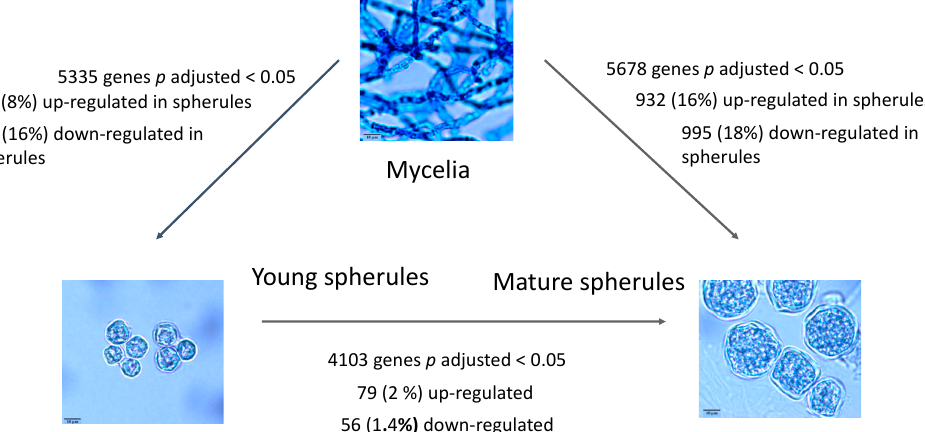
Figure 1. Differential expression of genes in mycelia, young and mature spherules. Legend Figure 1: mRNA was obtained from mycelia, young spherules and mature spherules for RNA-Seq. The morphology of the organism and the number of differentially expressed genes is shown.